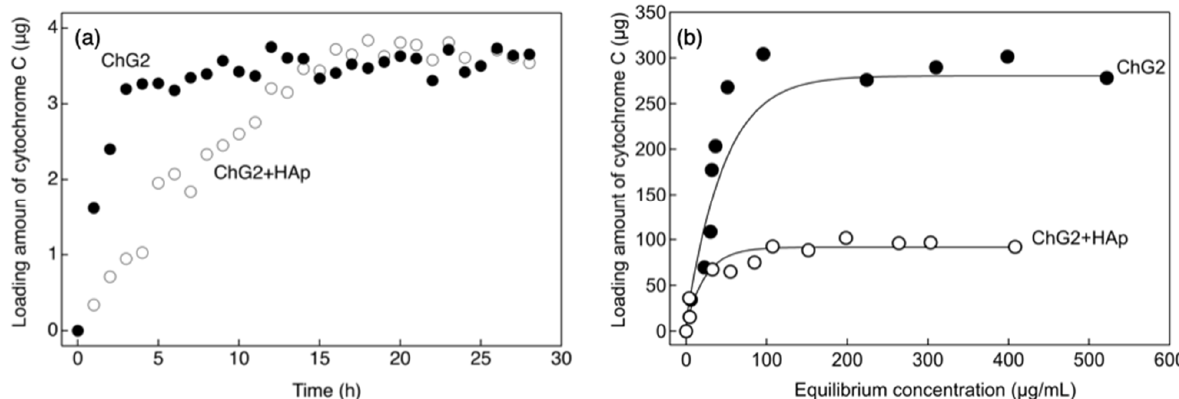
Figure 8. Amount of cytochrome C loaded into the capsules by the impregnation method. ( a ) Per capsule as a function of time at an equilibrium concentration of 200 μ g/mL, ( b ) per ten capsules as a function of equilibrium concentration at 24 h.